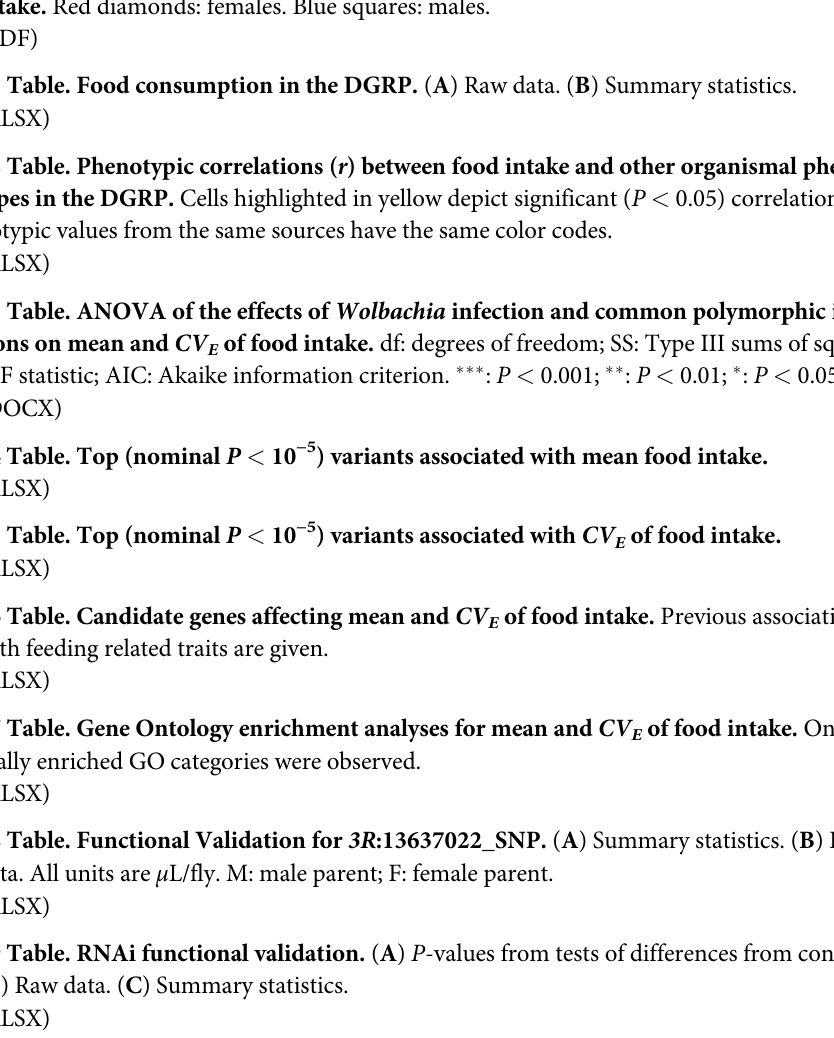
S10 Table. Summary of genes validated by RNAi knock